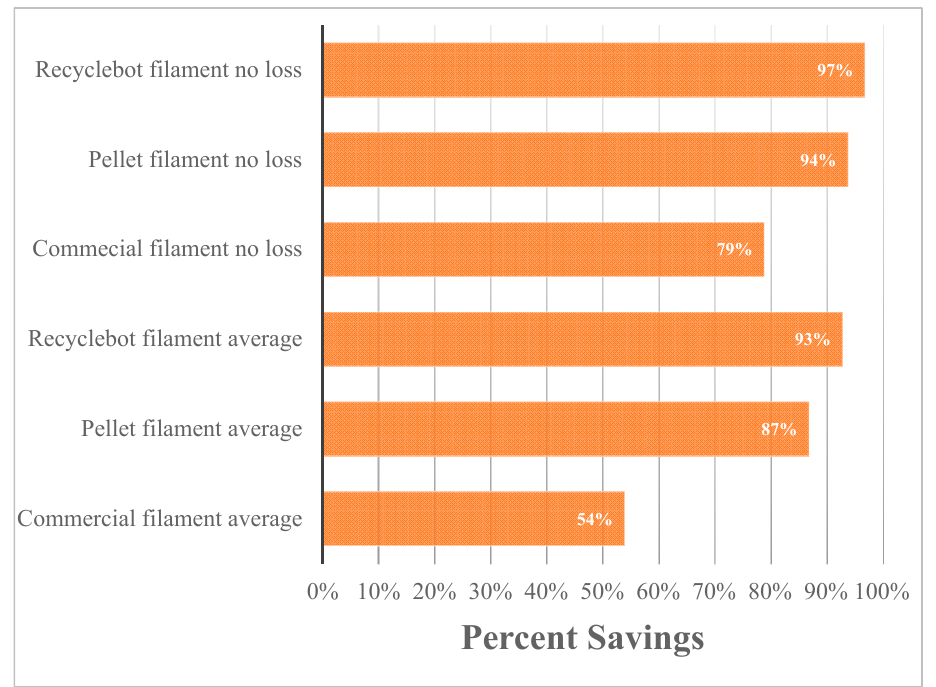
Figure 2. Bar chart showing the percent savings of printing designs with various filament types.